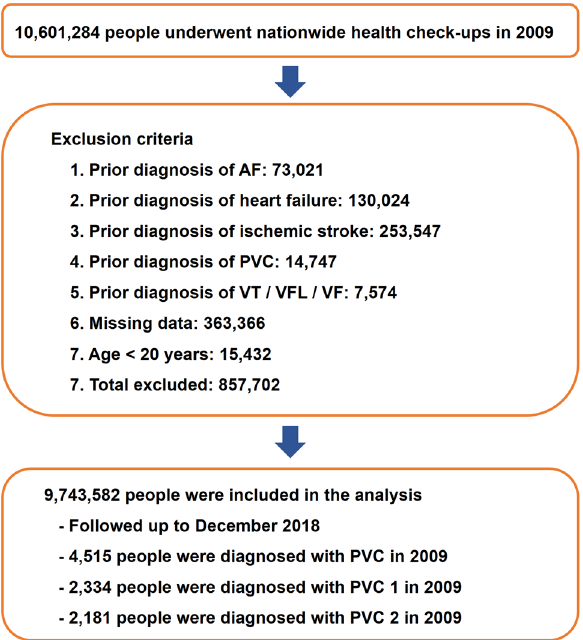
Figure 1. Flow diagram of the study. AF atrial fibrillation; PVC premature ventricular contraction; SCD sudden cardiac death; VF ventricular fibrillation; VFL ventricular flutter; VT ventricular